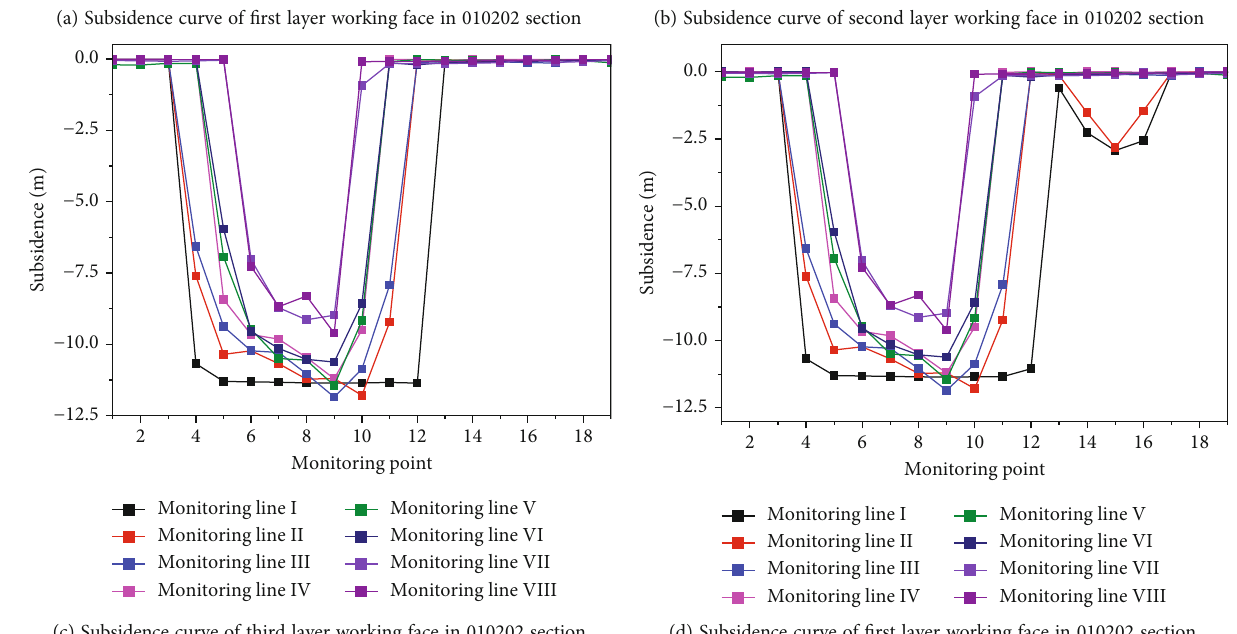
Figure 11: Schematic diagram of overburden subsidence in strati fi ed mining of thick coal